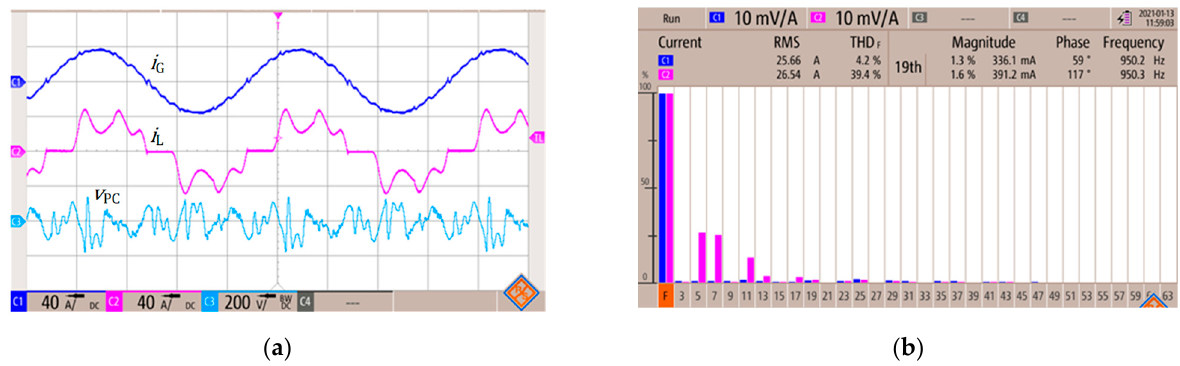
Figure 20. Operation of HAPF with the load Ld3: ( a ) the grid current, the load current and the power converter voltage waveforms; ( b ) harmonic spectrum of the grid and the load currents. Table 5. Comparison of the load currents and the grid currents for HAPF with the load Ld3.